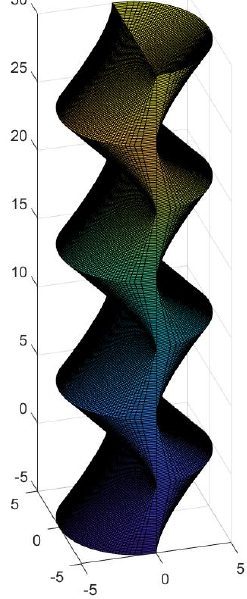
Figure 41. Different perspectives of the tubule.